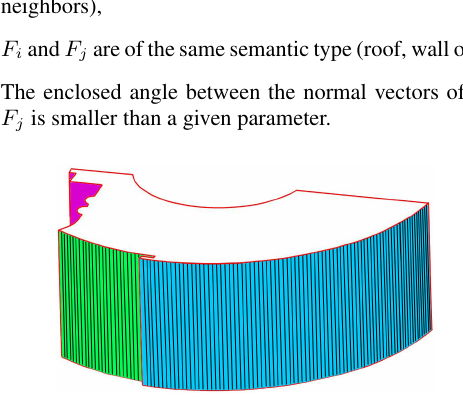
Figure 13. Polygons of a building separated into collections After all the polygons have been assigned, new boundary curves have to be defined for each collection in step (2). They con- sist of a composition of the original edges and are to represent the boundaries of potentially emerging B-spline surfaces. The boundary curves for the building in Figure 13 are highlighted in red.